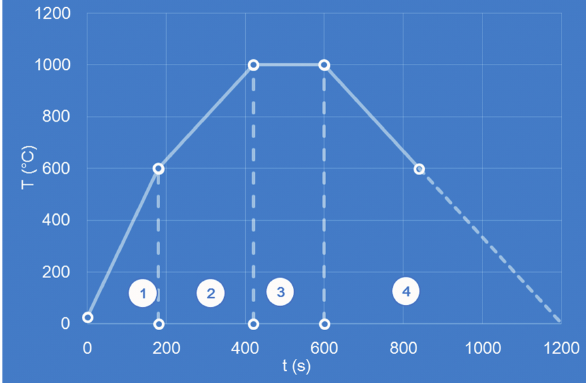
Figure 1: Scheme of sintering regimes: 1 – heating 200 °C/min, 2 – heating 100 K/min, 3 – isothermal holding, 4 – cooling 100 °C/min and free cooling after